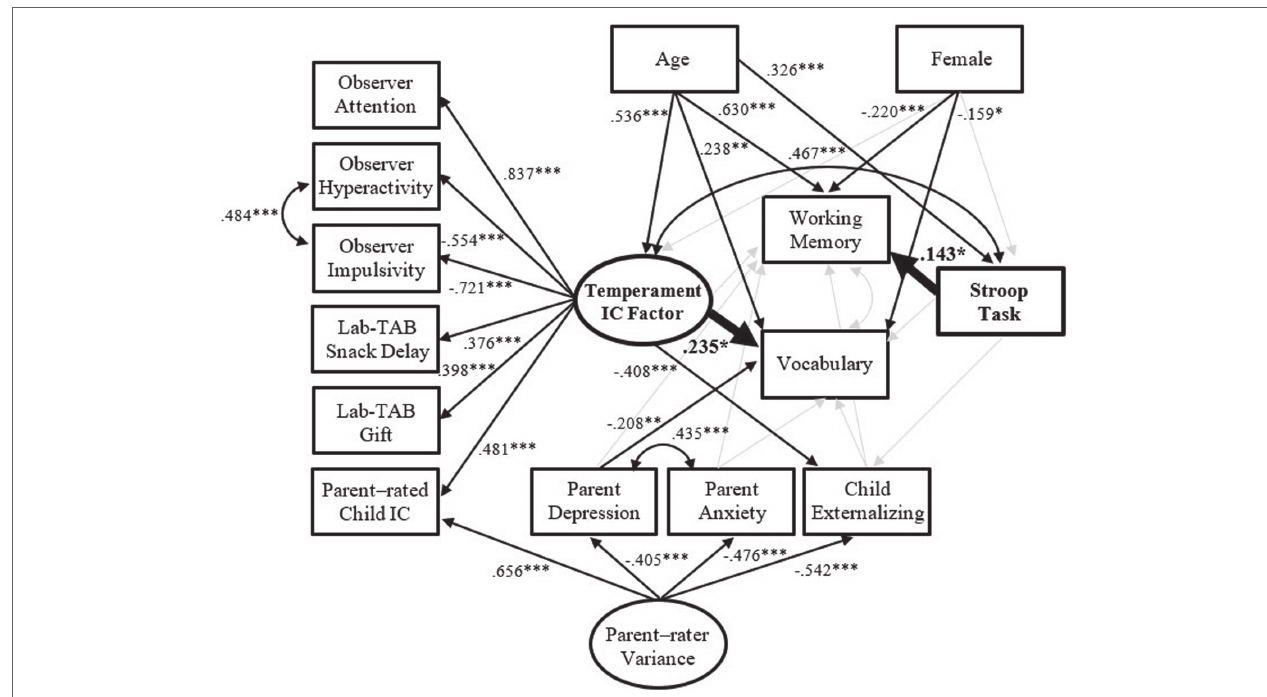
FIGURE 1 | The results of hypothesized model. Gray paths are not statistically significant. Values are standardized path coefficients. * p < 0.05; ** p < 0.01; and *** p <